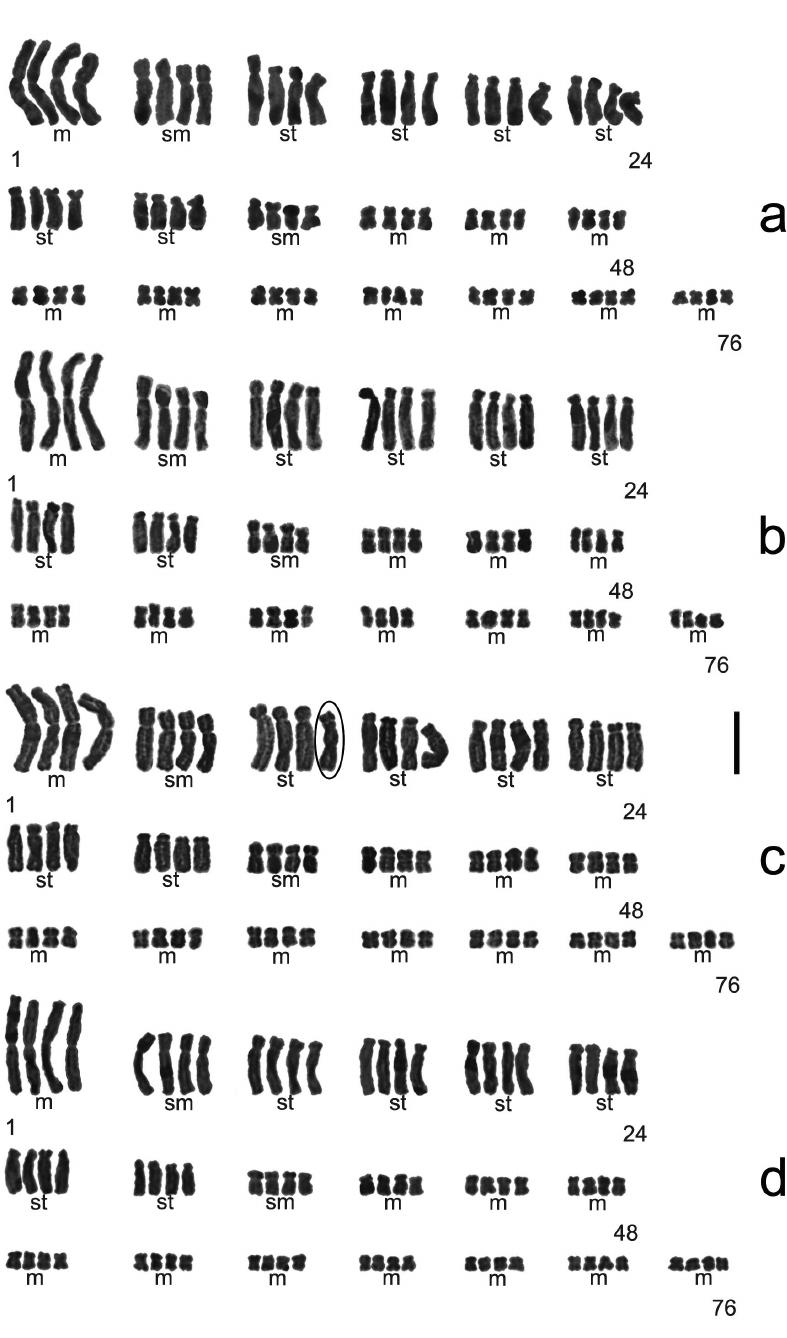
Figure 3. Karyotype of Aspidistra subrotata of 2n = 76, formulated as 2n = 44 m + 8 sm + 24 st. a Jilong population b 5th boundary marker population c Nonggang National Nature Reserve population, and the empty ellipse shows the presence of the secondary constriction on the chromosome 12 d 4th boundary marker population. Bar = 10